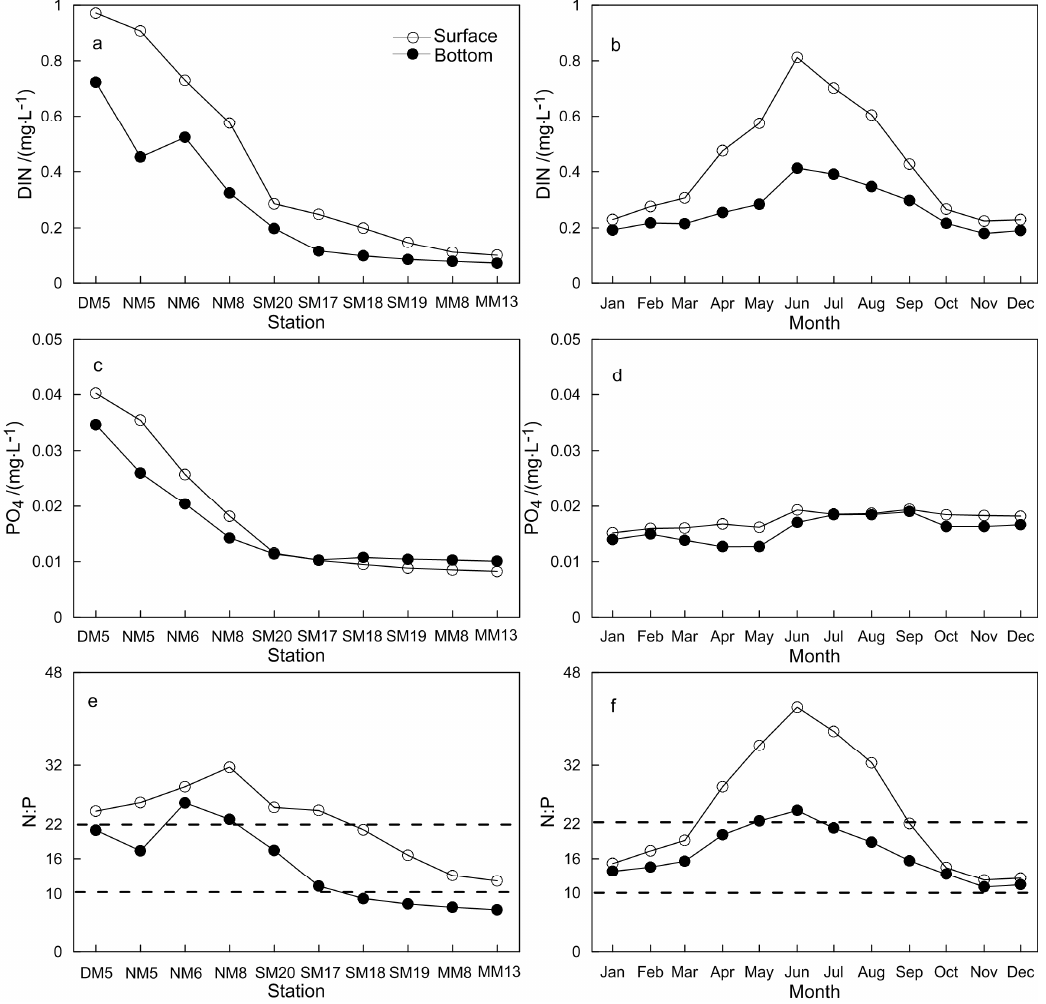
Figure 4. Variabilities of DIN, PO 4 , and N: P during the period 2000 − 2017. ( a , c , e ) Annual average at each station; ( b , d , f ) monthly average at all stations.